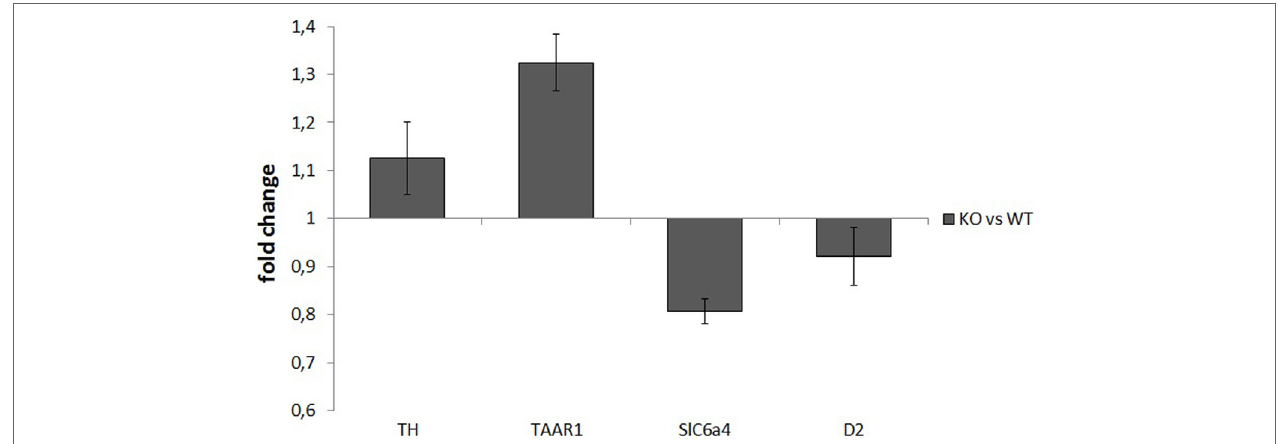
FigUre 5 | Normalized expression rates [knockout (KO)/wild-type (WT)] of tyrosine hydroxylase (TH), trace amine-associated receptor 1 (TAAR1), serotonin transporter (Slc6a4), and dopamine receptor 2 (D2), in ventral striatum samples of rats. For each of the assayed genes, there were no significant differences in expression levels between WT and KO